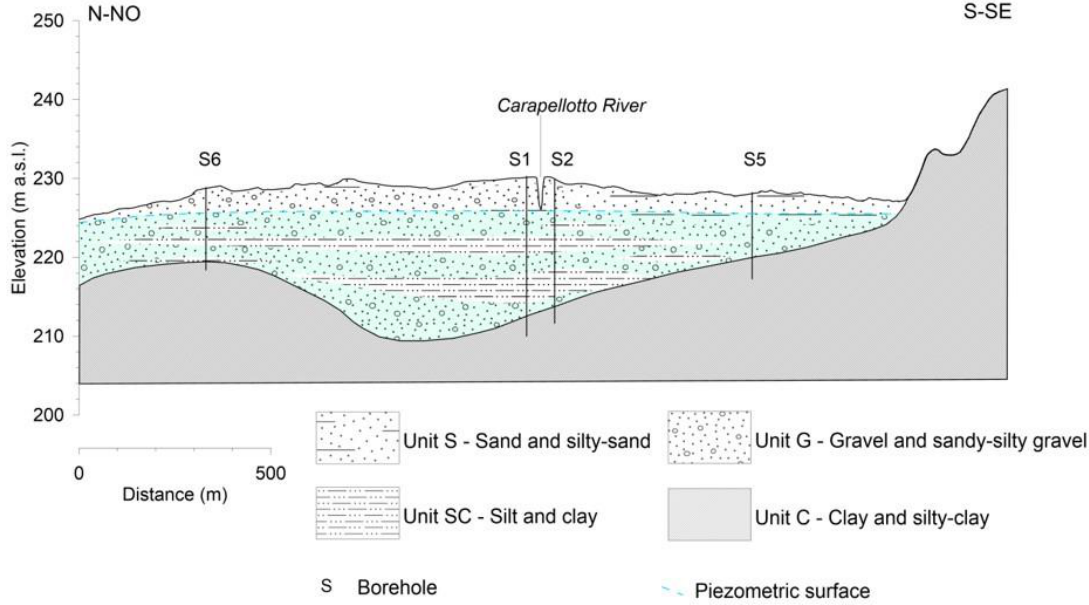
Figure 7. Hydro-stratigraphic cross-section along the monitored station in the Carapellotto river (location shown in Figure 6).